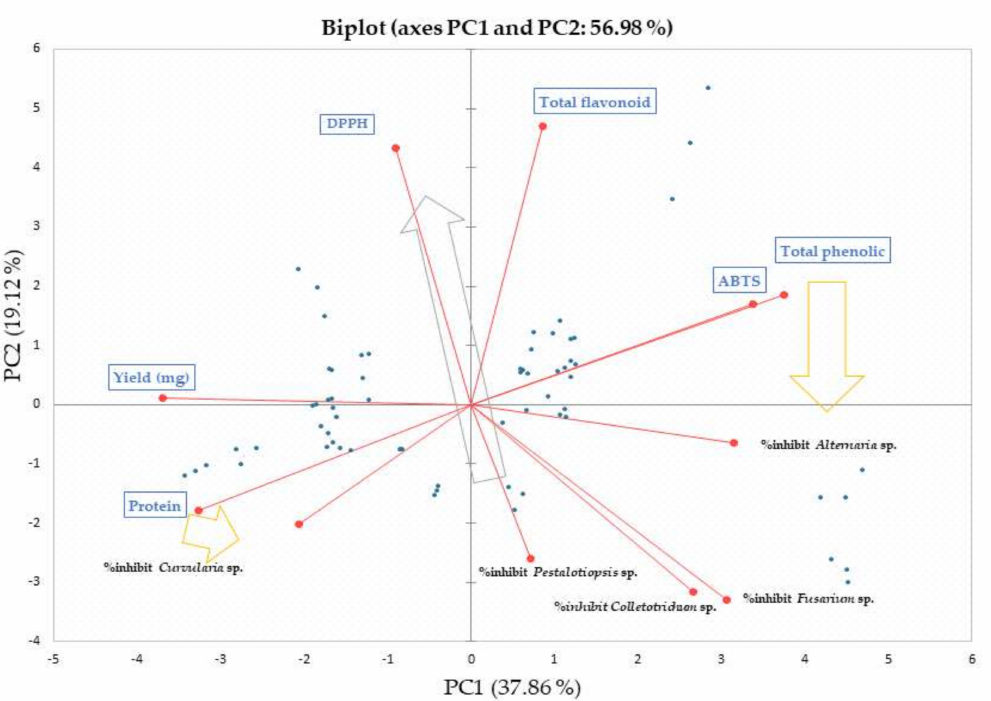
Figure 8. Chemometric score plot of the antifungal activities described as a percentage of inhibition. Alternaria sp. (CRC 152), Colletotrichum sp. (CRC 149), Curvularia sp. (CRC 162), Fusarium sp. (CRC 161), and Pestalotiopsis sp. (CRC